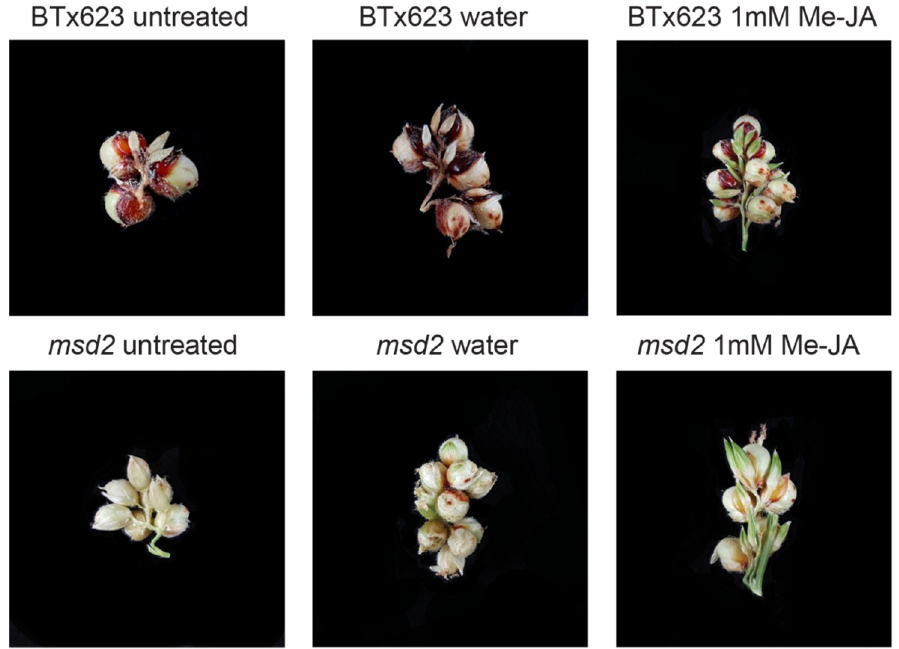
Figure 2. Phenotypic rescue of msd2 plants with exogenous application of methyl-JA. Wild type (WT) and msd2 lines were treated every 48 h with either water + 0.05% Tween-20 or 1 mM Me-JA + 0.05% Tween-20.